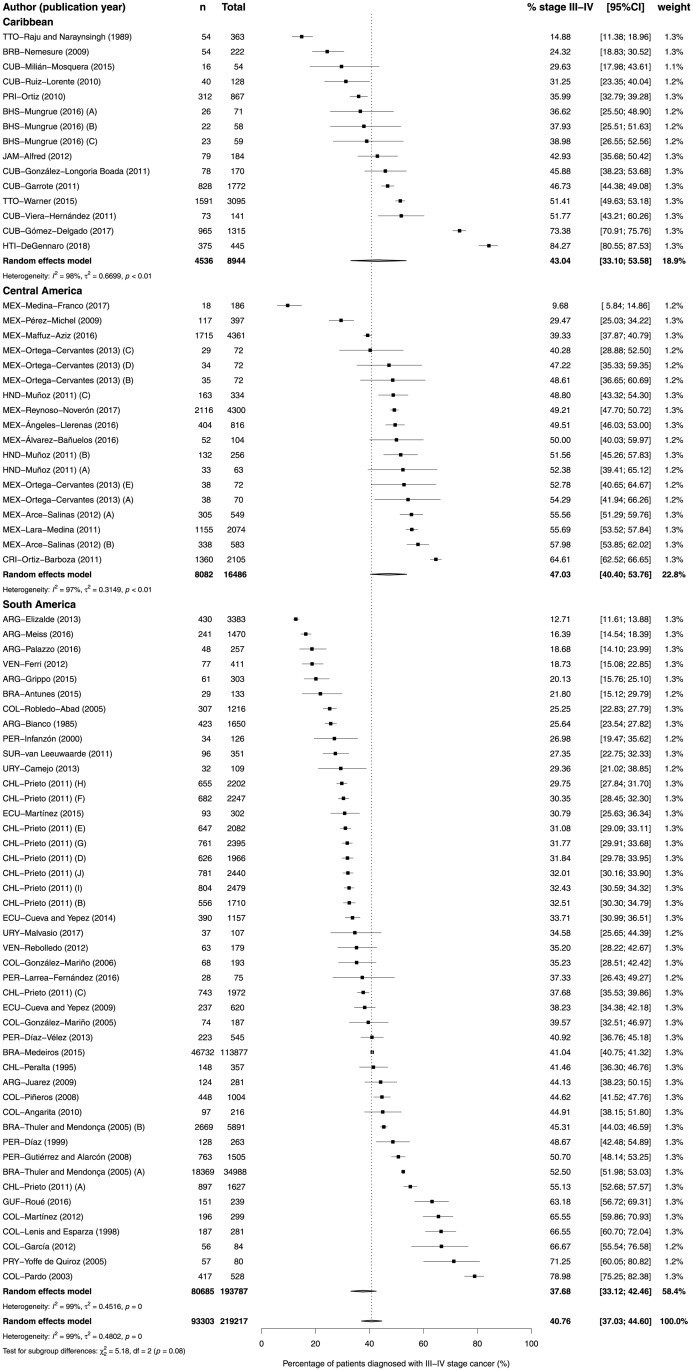
Forest-plot of percentage of stage III-IV breast cancer at diagnosis, by region of Latin America and Caribbean.Percentage of T3/T4 cancers were used as proxy of stages III/IV for SUR-van Leeuwaarde (2011). Regional and distant disease were considered as stages III and IV for CRI-Ortiz-Barboza (2011), CUB-Garrote (2011), and PRI-Ortiz (2010). The study GUY-Taioli (2010) was not included because it provided the proportion of patients diagnosed with stages I-III (93%) and stage IV (7%). Recruitment or diagnosis years: BHS-Mungrue (2016) A→C = 2009→2011; BRA-Thuler and Mendonça (2005) A = 1990–1994 B = 1995–2002; CHL-Prieto (2011) A→J = 2000→2011; HND-Muñoz (2011) A = 1999 B = 2000–2004 C = 2005–2009; MEX-Ortega-Cervantes (2013) A→E = 2006→2010; MEX-Arce-Salinas (2012) A = 2008 B = 2009. Study references are given in the Supporting Information (S3 File).